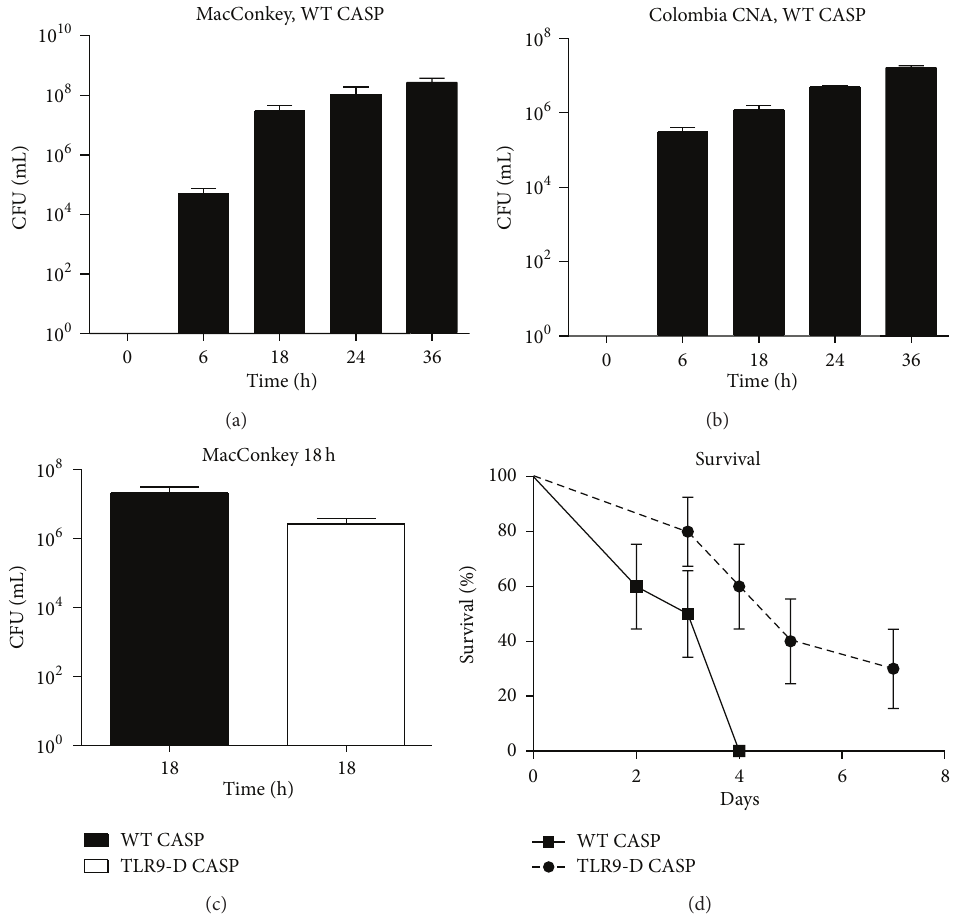
Figure 1: Intraperitoneal colony-forming units (CFUs) and survival after CASP. (a) + (b) Time course of CFUs on MacConkey (a) and Colombia + CNA (b) agar from peritoneal fluid of WT-CASP mice at 0, 6, 18, 24, and 36 hours after surgery ( 𝑛 = 15 /group). (c) Comparison of intraperitoneal CFUs between WT CASP and TLR9-D CASP mice 18h after surgery ( 𝑛 = 15 /group). (d) Survival rate in WT CASP and TLR9-D CASP following surgery plotted as the Kaplan-Meier survival curve. Curves were significantly different ( 𝑃 = 0.0056 ; 𝑛 = 10 /group; mean ±